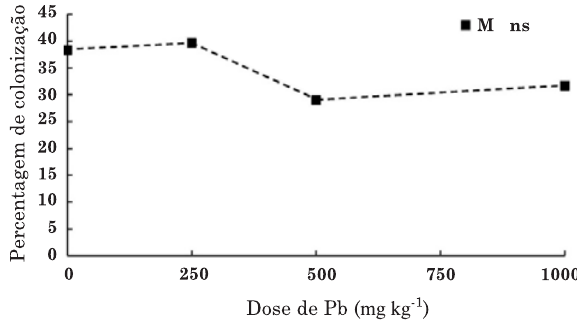
Figura 4. Percentagem de colonização micorrízica em raízes de plantas de Stizolobium aterrimum em resposta ao incremento da dose de Pb no solo. (ns: regressão não